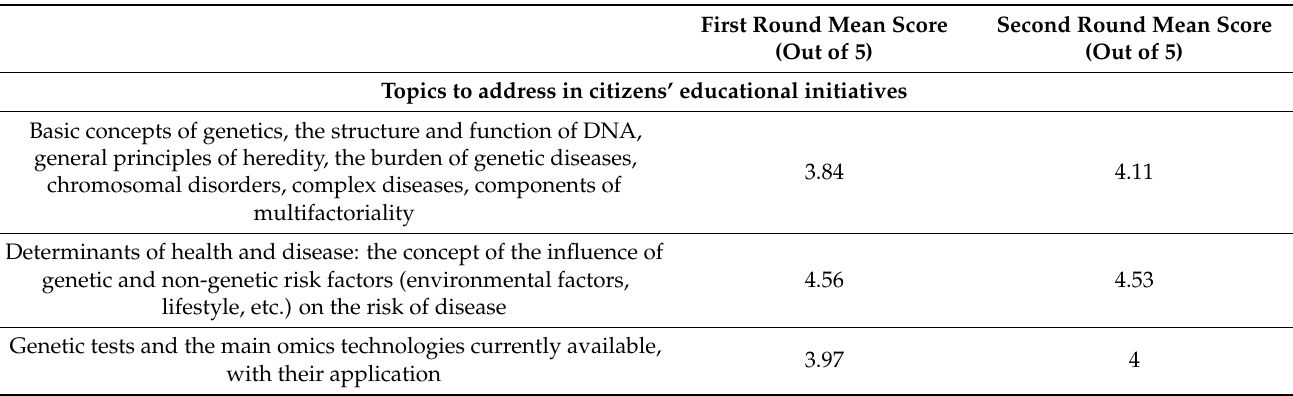
Table 1. Items included in the first version of the survey and the results of the first and second rounds of the Delphi